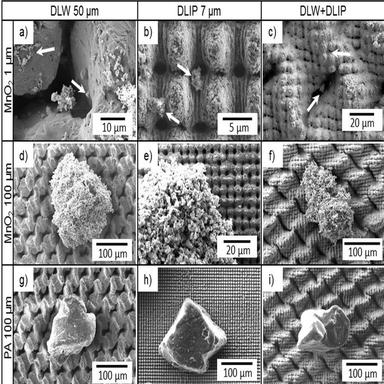
Scanning electron microscope images of the DLW (a, d, g), DLIP (b, e, h) and DLW + DLIP (c, f, i) structures with different contamination types: 1 µm sized MnO2 (a–c), 100 µm MnO2 (d–f) and 100 µm PA (g–i).